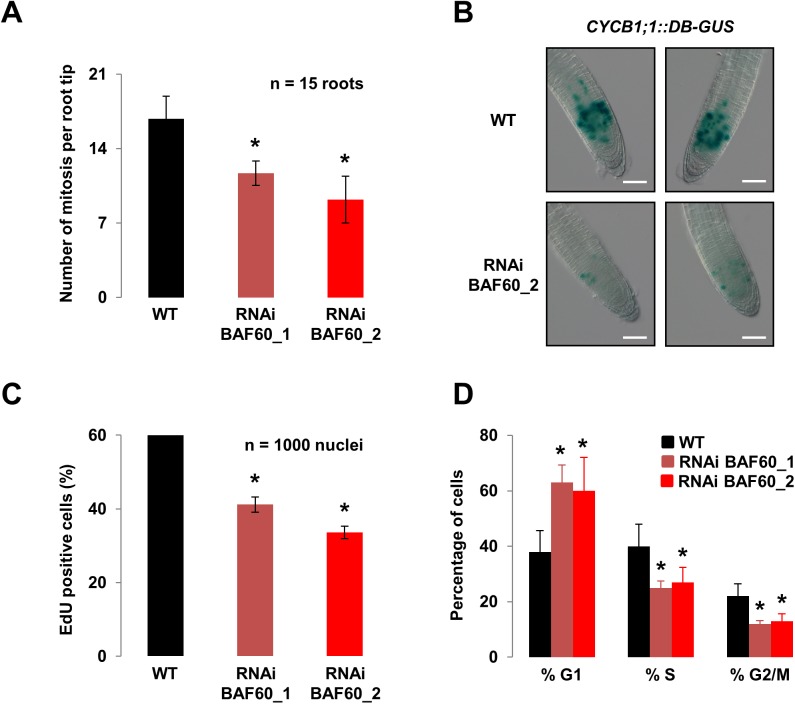
BAF60 control cell cycle progression.(A) Mitotic index in root tips of 7-day-old wild-type and BAF60 RNAi plantlets grown vertically on MS medium. Values are average +/- standard deviation of biological triplicates. Asterisks indicate significant difference from the wild type (WT) (P < 0.01, Student’s t test). (B) Histochemical staining of the GUS activity in wild-type and BAF60_2 RNAi roots harbouring the CYCB1;1::DB-GUS construct. The number of stained cells reflects the number of cells in G2/M. Plantlets were grown vertically for 7 days on MS medium. Bars = 100 μm. (C) Proportion of EdU positive cells in the root tips of seven-day-old wild-type and BAF60 RNAi lines grown vertically on MS medium. Values are average +/- standard deviation of biological triplicates. Asterisks indicate significant difference from the wild type (WT) (P < 0.01, Student’s t test). (D) Cell cycle progression was examined by flow cytometry. Histograms show the percentage of cells in G1, S and G2/M phases in wild-type and BAF60 RNAi root-derived protoplasts. Plantlets were grown vertically for 7 days on MS medium before protoplast preparation. Data presented are representative of three biological replicates. Asterisks indicate significant difference from the wild type (WT) (P < 0.05, Student’s t test).